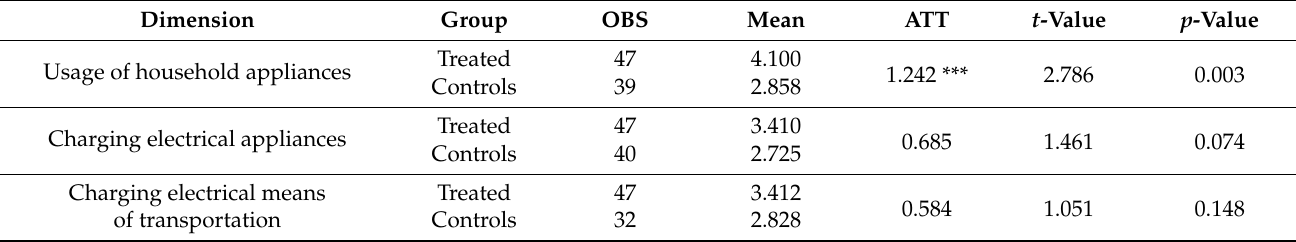
Table 10. Demand flexibility comparisons of Solar-consellers (treated) versus Solar-consumers controls) (source: